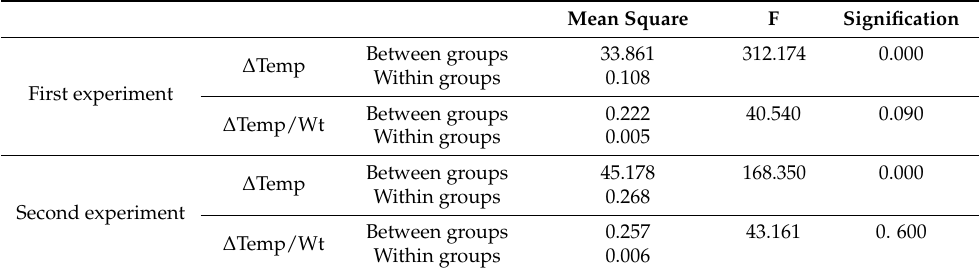
Table 7. ANOVA results comparing the mean of ∆ Temp and ∆ Temp/Wt.